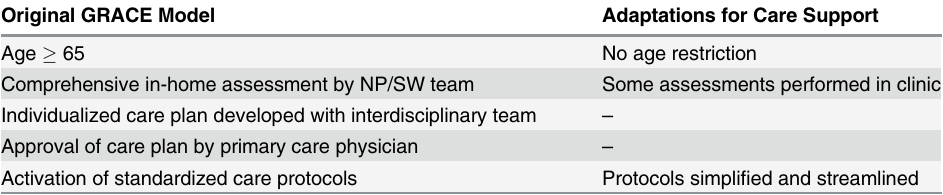
Table 3. Core Components of GRACE and Adaptations for Care